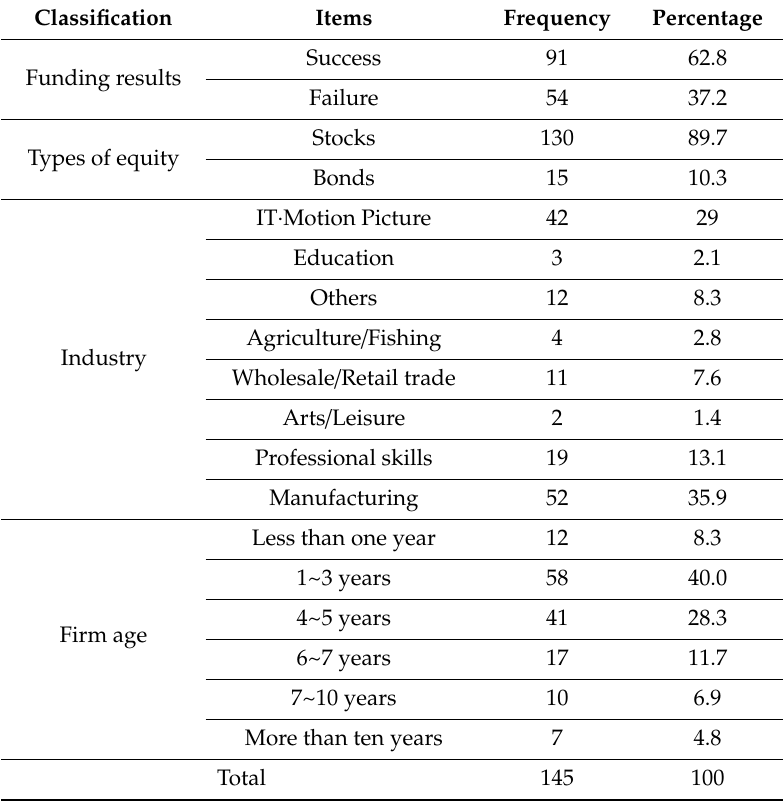
Table 4. Summary of sample characteristics.